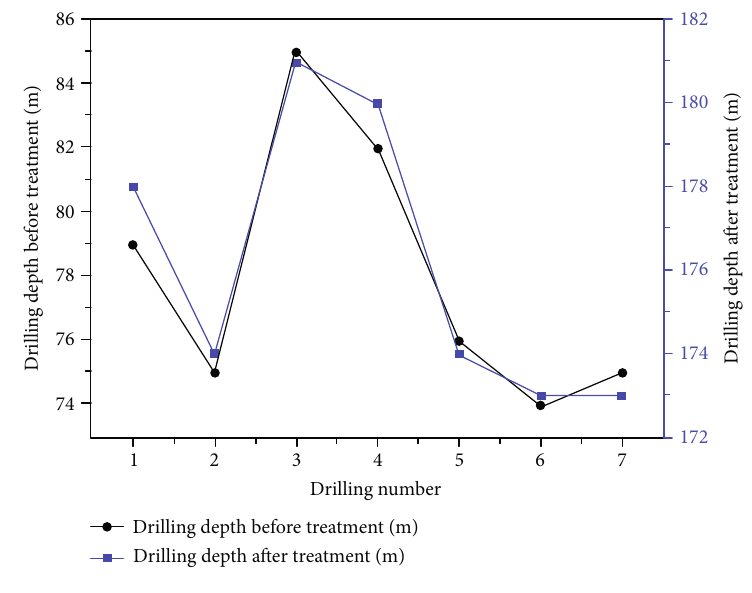
Figure 5: Comparison of dedusting drilling depth.